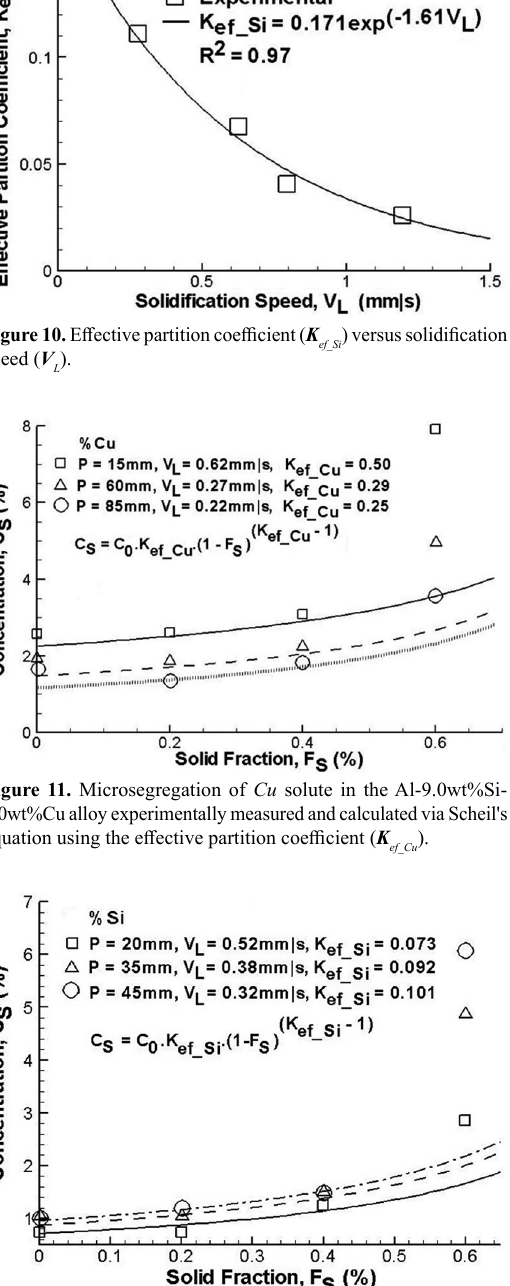
Figure 12. Microsegregation of Si solute in the ternary Al-9.0wt%Si- 4.0wt%Cu alloy experimentally measured and calculated via Scheil's equation using the effective partition coefficient ( K